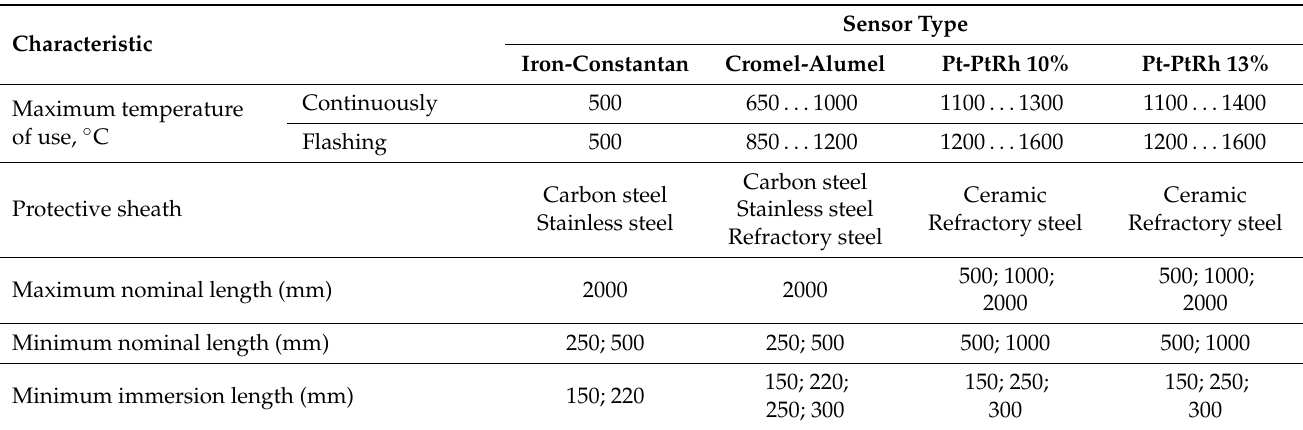
Table 2. The characteristics of the temperature sensors used.